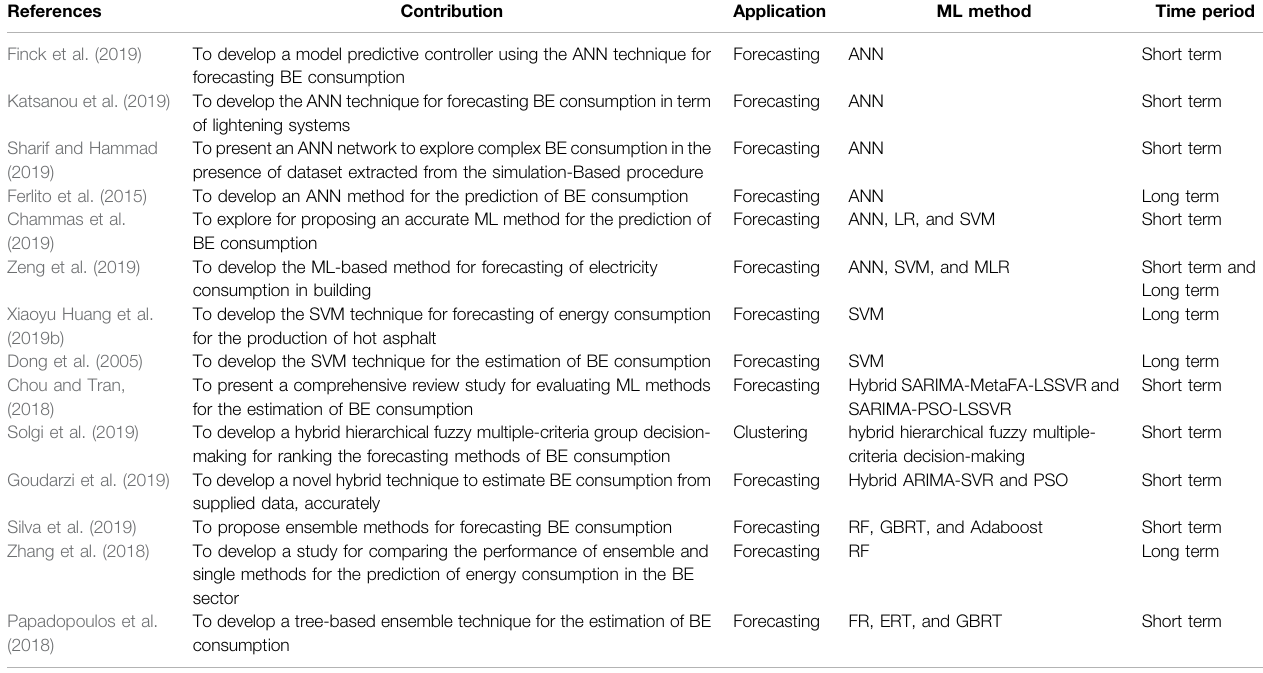
TABLE 4 | Studies developed by ML techniques for forecasting BE